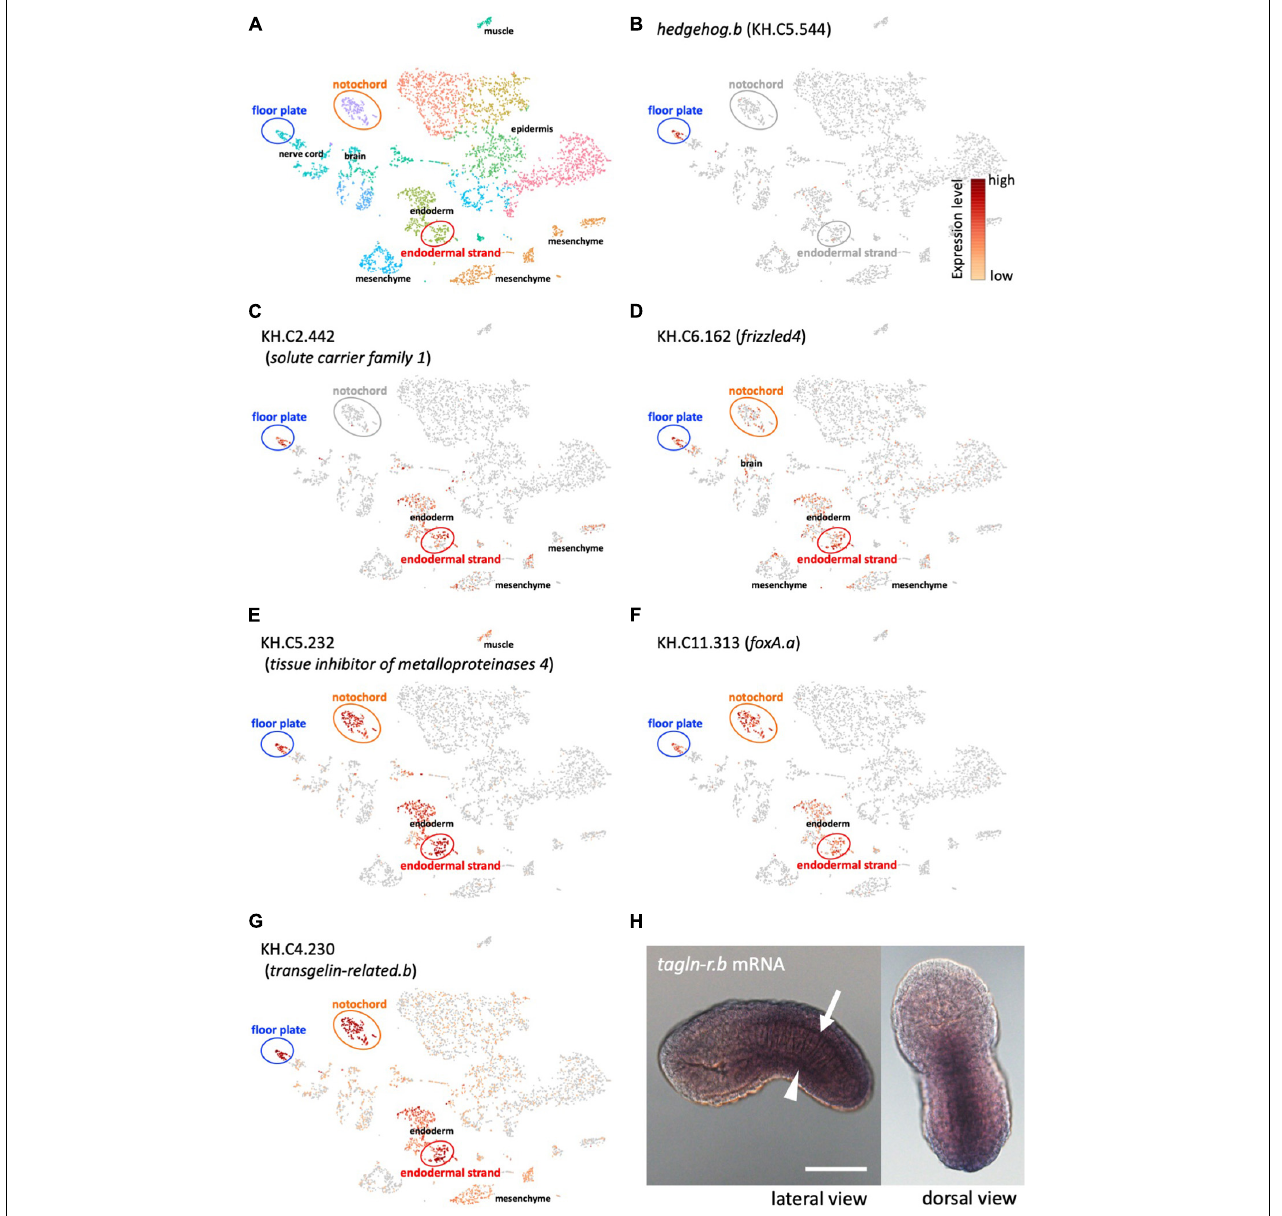
FIGURE 2 | Whole-embryo single-cell RNA-seq analysis of midline tissue-specific genes. (A) A t-distributed stochastic neighbor embedding (t-SNE) projection map of mid-tailbud stage embryos obtained in a previous study (Horie T. et al., 2018). Each dot corresponds to the transcriptome of a single cell, and cells possessing similar transcriptome profiles map near each other. The major tissue types in tailbud-stage embryos were identified. Identification of tissue types is based on the expression of known marker genes as previously described (Horie T. et al., 2018). Clusters of cells corresponding to the floor plate, the notochord, and the endodermal strand are encircled. (B) The t-SNE projection map highlighting hedgehog.b -expressing cells (red dots) in the floor plate. (C–G) The t-SNE projection map showing the expression profiles of representative genes that are specifically expressed in both the floor plate and the endodermal strand ( Table 1 ). Red and orange dots indicate cells expressing KH.C2.442 (C) , KH.C6.162 ( frizzled4 , D) , KH.C5.232 (E) , KH.C11.313 ( foxA.a , F) , and KH.C4.230 ( tagln-r.b , G) . (H) Expression pattern of tagln-r.b at the tailbud stage visualized by whole-mount in situ hybridization. The arrow and the arrowhead indicate the floor plate and the endodermal strand, respectively. Scale bar, 50 µ